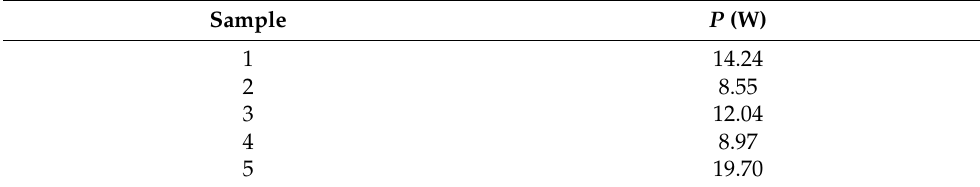
Table 8. Thermal power of the tested